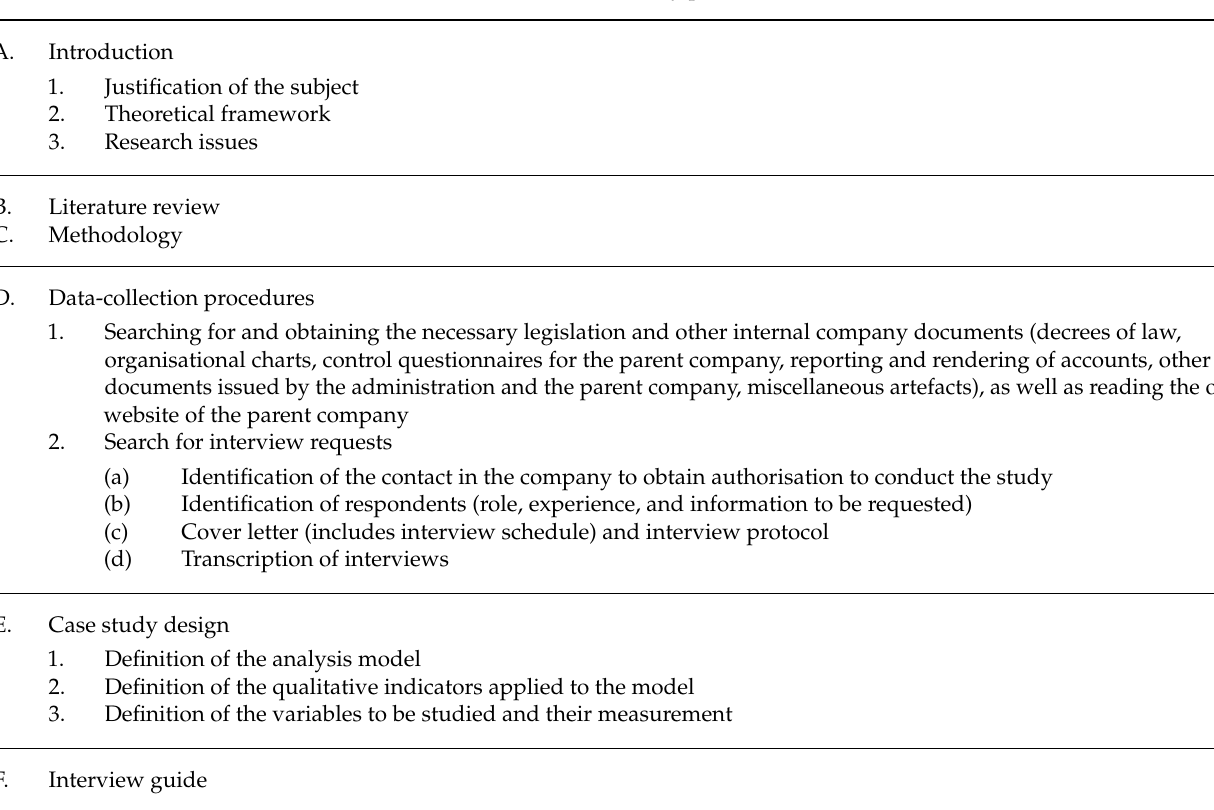
Figure 2 - Case study design (adapted from Yin [77]). Figure 2. Case study design (adapted from Yin [76]). Table 2. Case-study